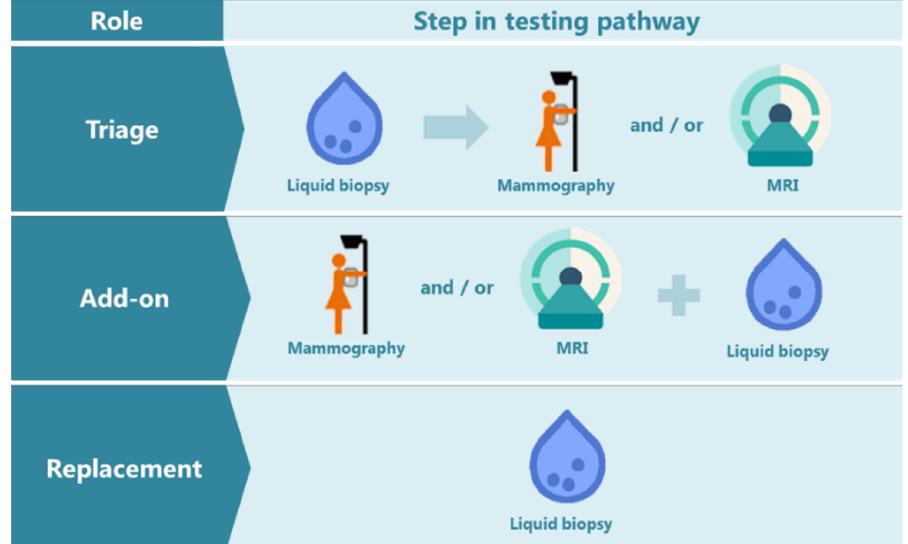
Figure 4. The possible roles of a liquid biopsy test in the breast cancer detection pathway: triage, add-on, or replacement test. MRI: Magnetic resonance imaging. The mammography schematic icon is adapted from the Dutch information folder for participation in the National Programme for Breast Cancer Screening [73].